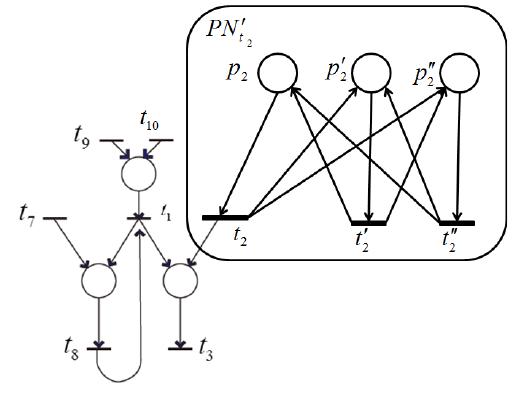
Figure 17. Example structure that cannot be shrunk into a single